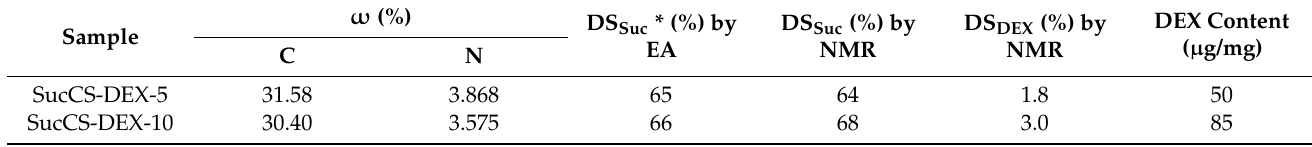
Table 2. Characterization of SucCS-DEX.